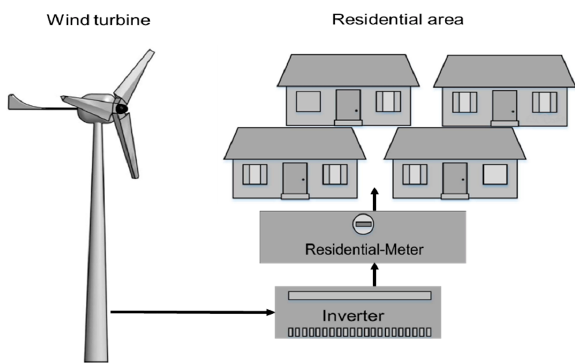
Figure 3. Simplified scheme of a wind energy conversion system. Reproduced from Becerra et al. [26], with permission from Elsevier. Copyright (2017) Elsevier Ltd.